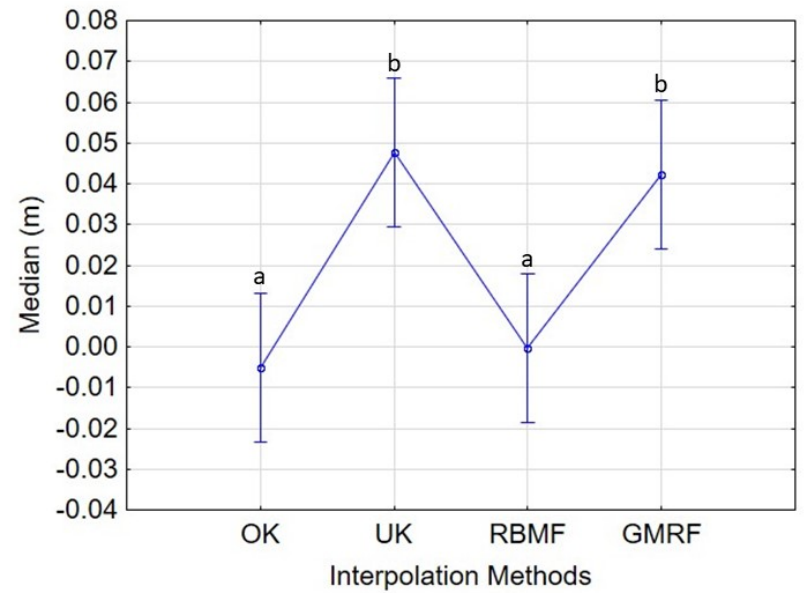
Figure 9. Trend graph of the median of the residuals (Z interpolated − Z checkpoint ) with respect to the factor Interpolation Method. Vertical bars denote 95% con fi dence intervals. Di ff erent le tt ers between inter- polation methods indicate signi fi cant di ff erences according to Tukey’s test ( p < 0.05).